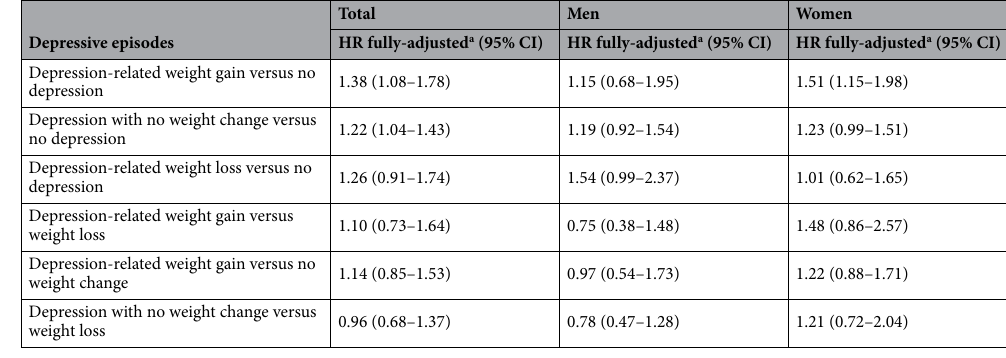
Table 4. Multivariable adjusted hazard models for depression-related weight change and incident type 2 diabetes adjusting for attained BMI category for Ontario adults in the NPHS 1996, CCHS Cycle 1.1, CCHS Cycle 2.1 (n = 59,315). Weighted using survey weights provided by Statistics Canada; all missing covariates imputed. a Estimates adjusted for age categories, sex, education, income, marital status, geography, born in Canada, ethnicity, smoking, alcohol consumption, physical activity levels, self-reported hypertension and heart disease, survey cycle, and attained BMI